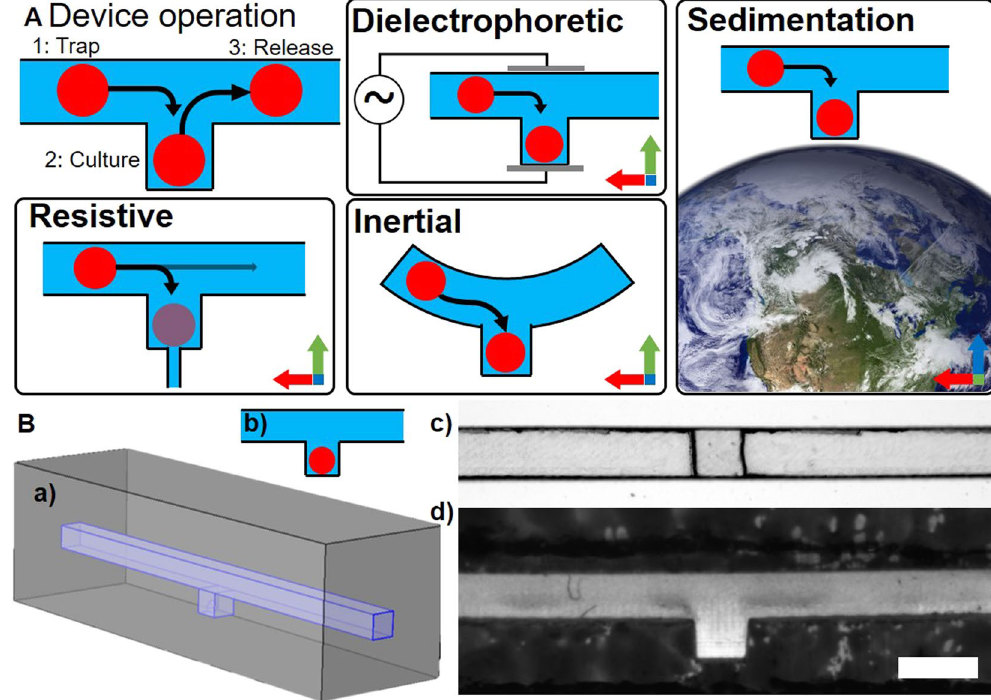
Figure 1. Basic MST designs: ( A ) MST operation with schematics of different trapping mechanisms: resistive, dielectrophoretic, inertial and sedimentation trapping; blue axis is parallel to gravity. The picture of the western hemisphere of earth on a transparent background was solely created by NASA and is in the public domain in the United States. ( B ) Simplified 3D (a) and 2D (b) MST design with a top (c) and side (d) view of a PDMS chip with these features; scale bar is 1000 μ